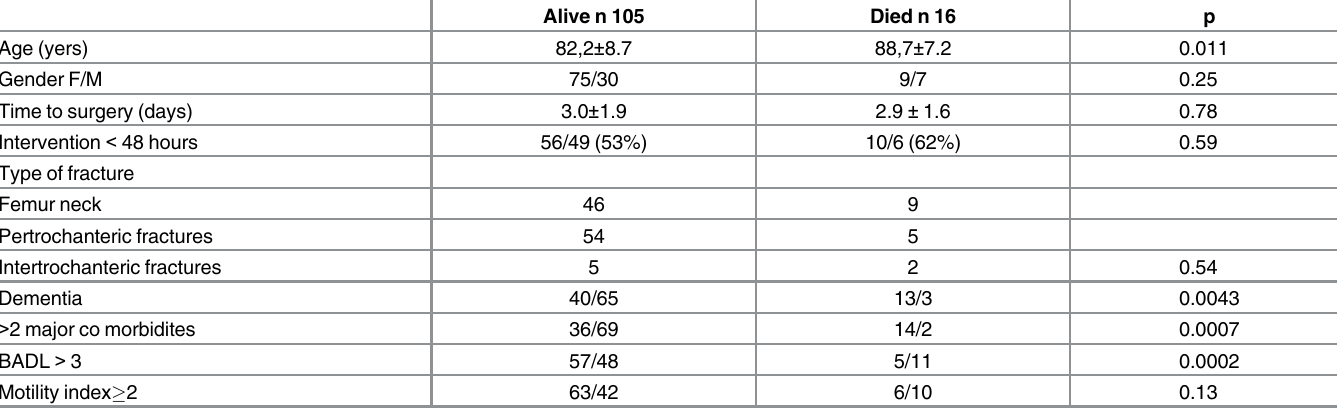
Table 4. Univariate analysis of factors related to 3-month mortality.